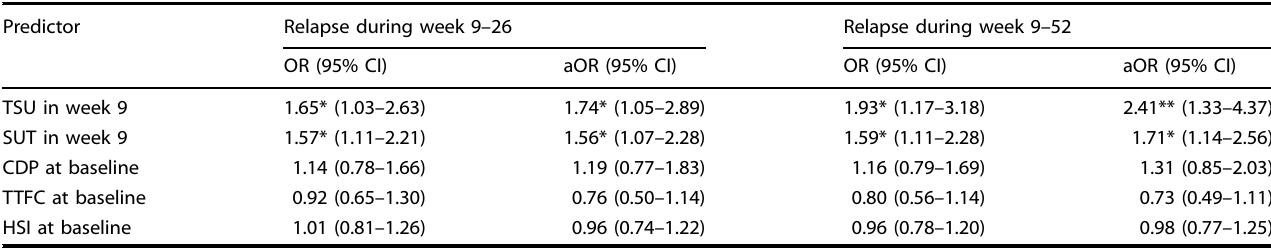
Table 1. Predictors of relapse during week 9 – 26 and week 9 – 52.